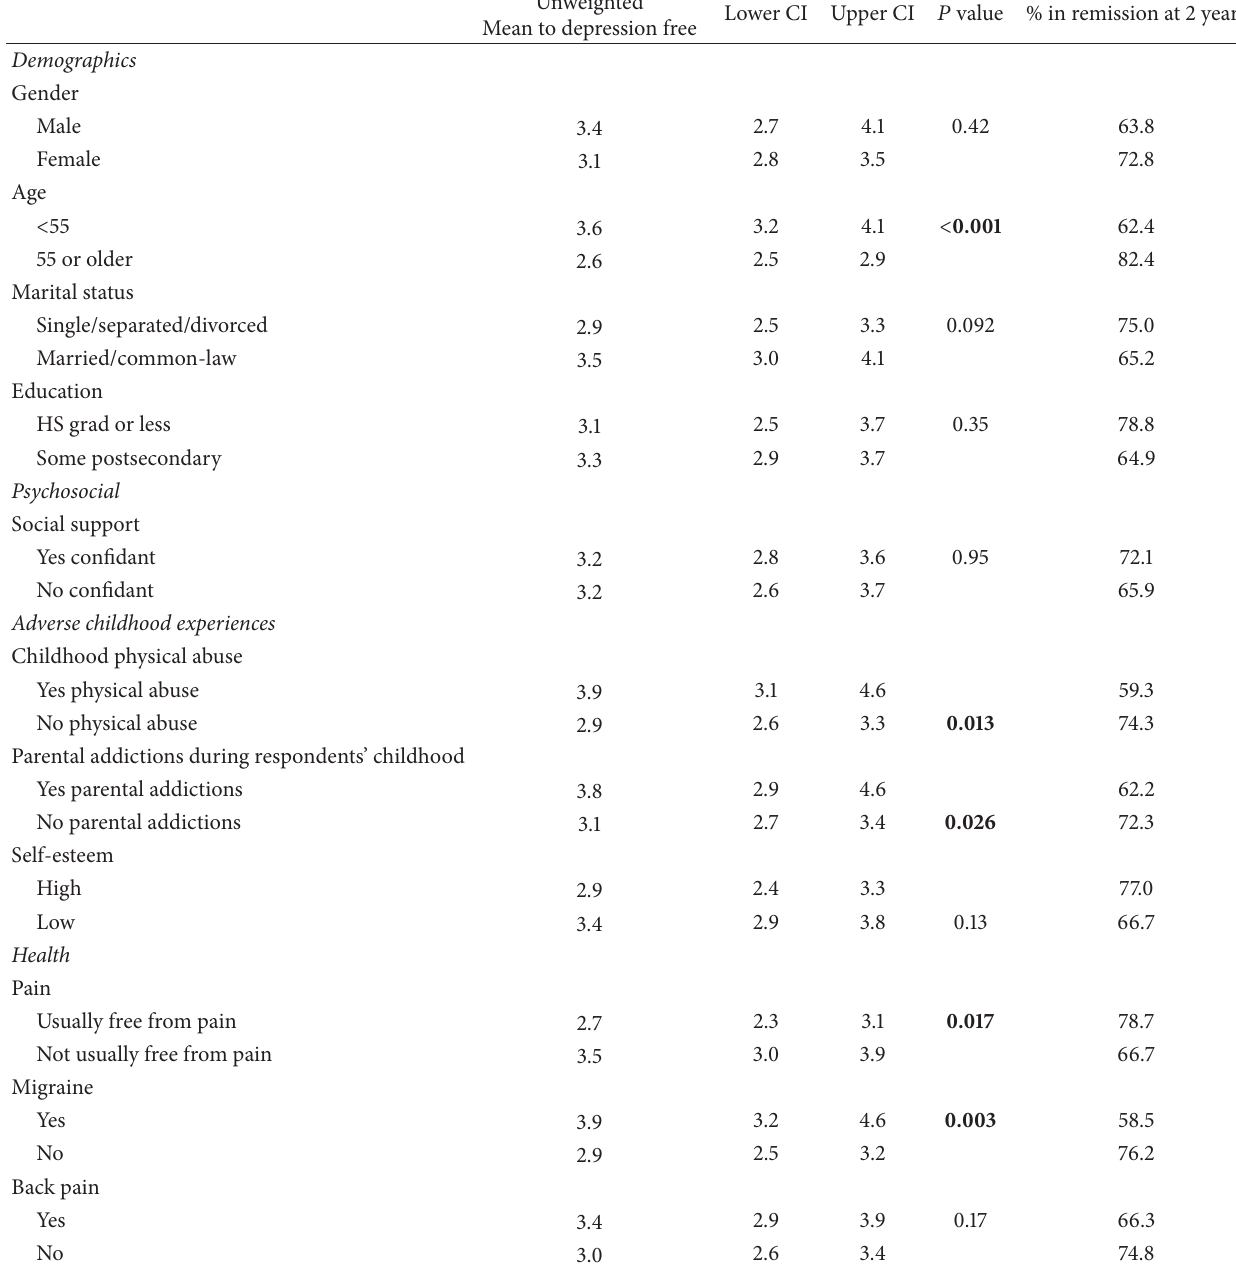
Table 1: Mean survival time and percent in remission at 2 years compared across categories of potential demographic, psychosocial, health, and health-behavioural